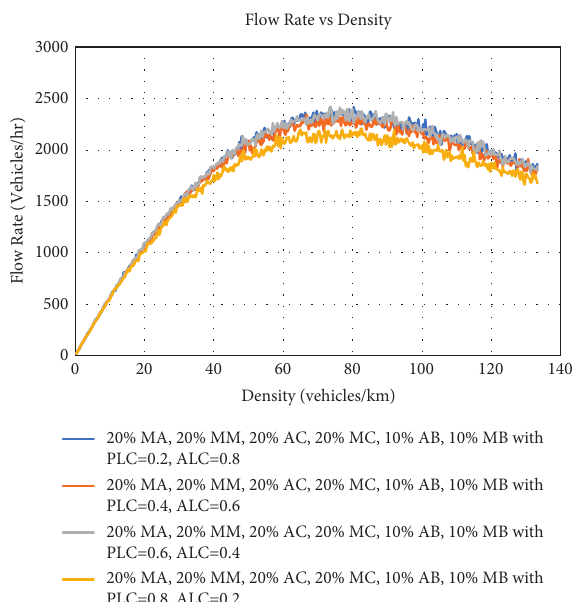
Figure 10: Flow rate vs. density fundamental diagrams for different compositions of MA, MM, AC, MC, AB, and MB with different values of ALC and PLC.